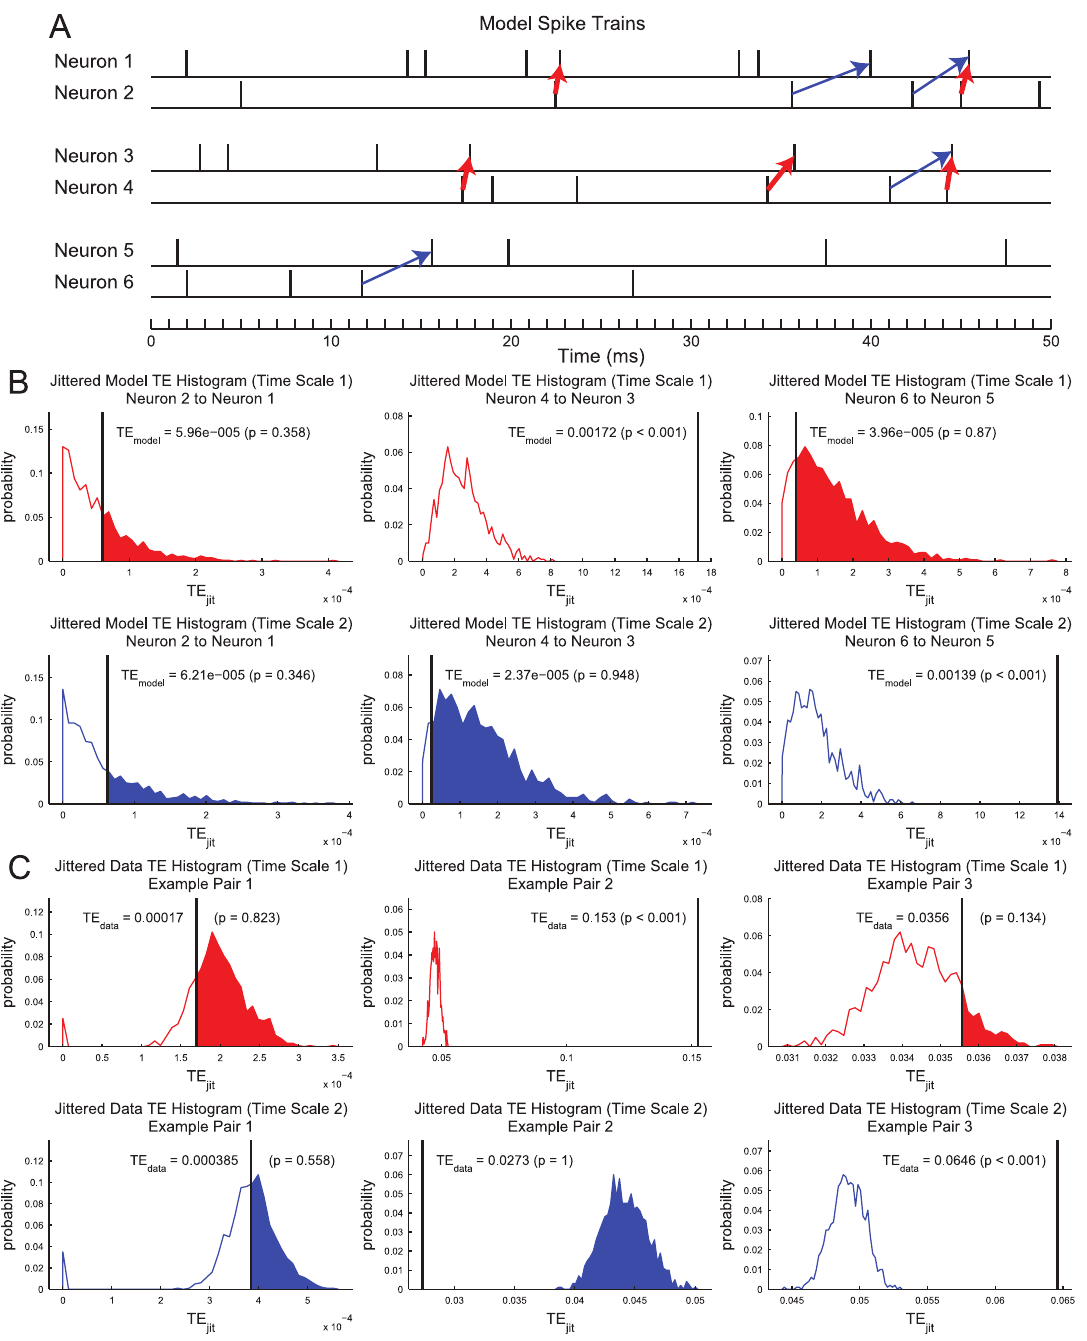
Fig. 11. The TE analysis method isolated time scale specific interactions. ( A ) Spike trains for 6 model neurons. All neurons spike randomly (Poisson) at 100 Hz and were recorded for 60 seconds. ( B ) Jittered TE histograms for the model neurons for the two shortest time scales. Neurons 1 and 2: Independent spiking. TE results are not significant for either time scale. Neurons 3 and 4:5% of neuron 3 spikes were moved to follow 1.5 ms after neuron 4 spikes. A significant TE result is found for the first time scale (0.05 ms to 3 ms), but not for the second time scale (1.6 ms to 6.4 ms). Neurons 5 and 6:5% of neuron 5 spikes were moved to follow 4 ms after neuron 6 spikes. A significant TE result is found for the second time scale (1.6 ms to 6.4 ms), but not for the first time scale (0.05 ms to 3 ms). ( C ) Example jittered TE histograms from real data that show similar features to model neuron